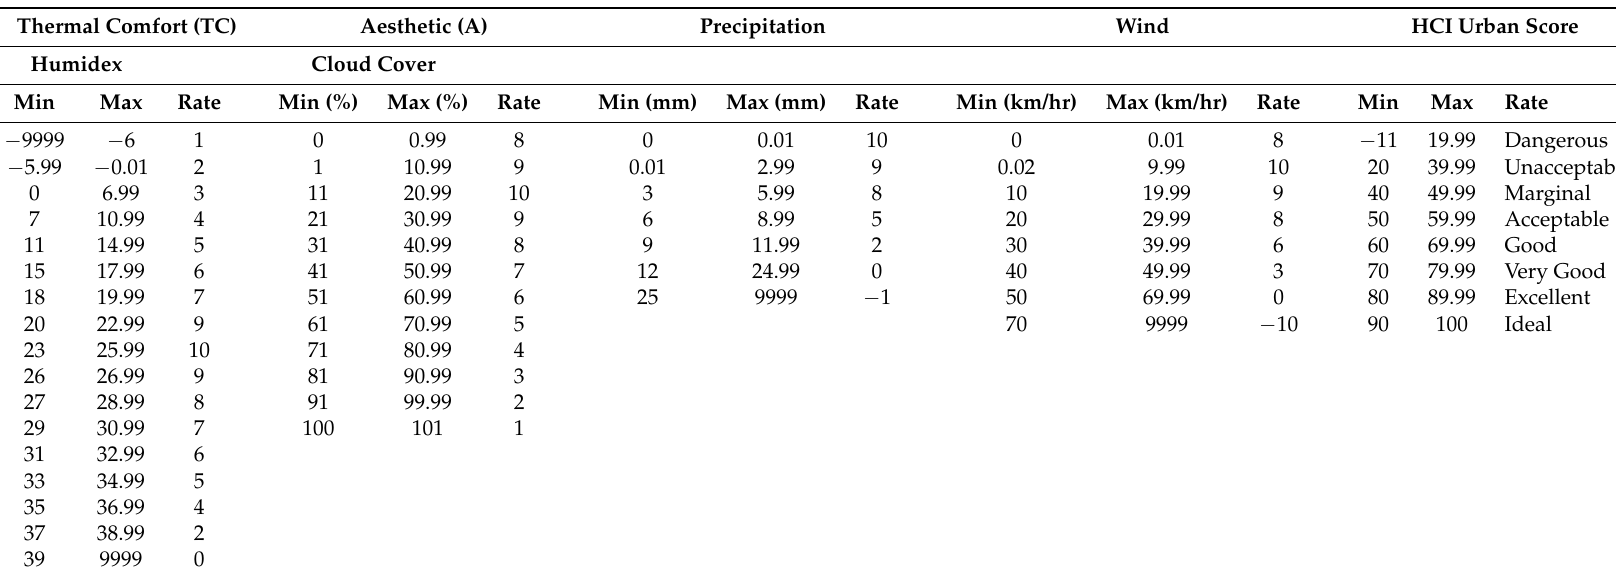
Table 2. The ratings of thermal comfort (according to Humidex), aesthetic (according to cloud cover ), precipitation, wind facets and HCI:Urban scores. Thermal Comfort